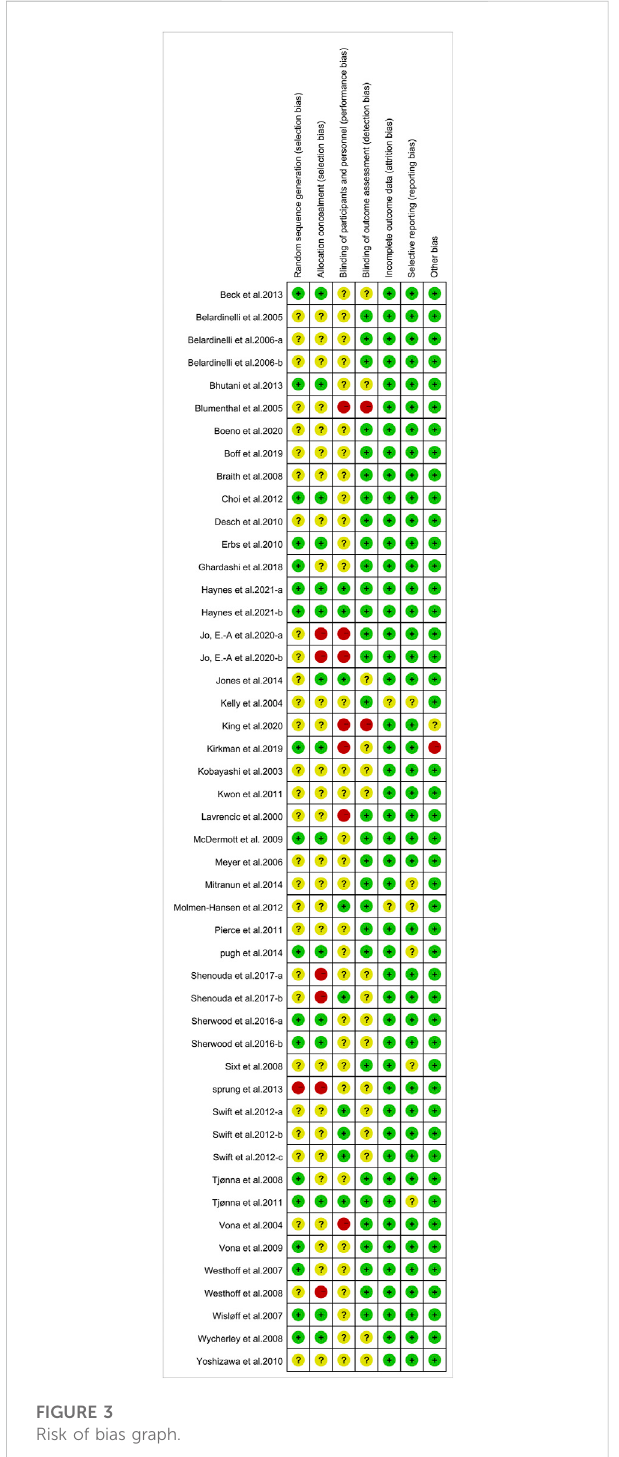
FIGURE 3 Risk of bias